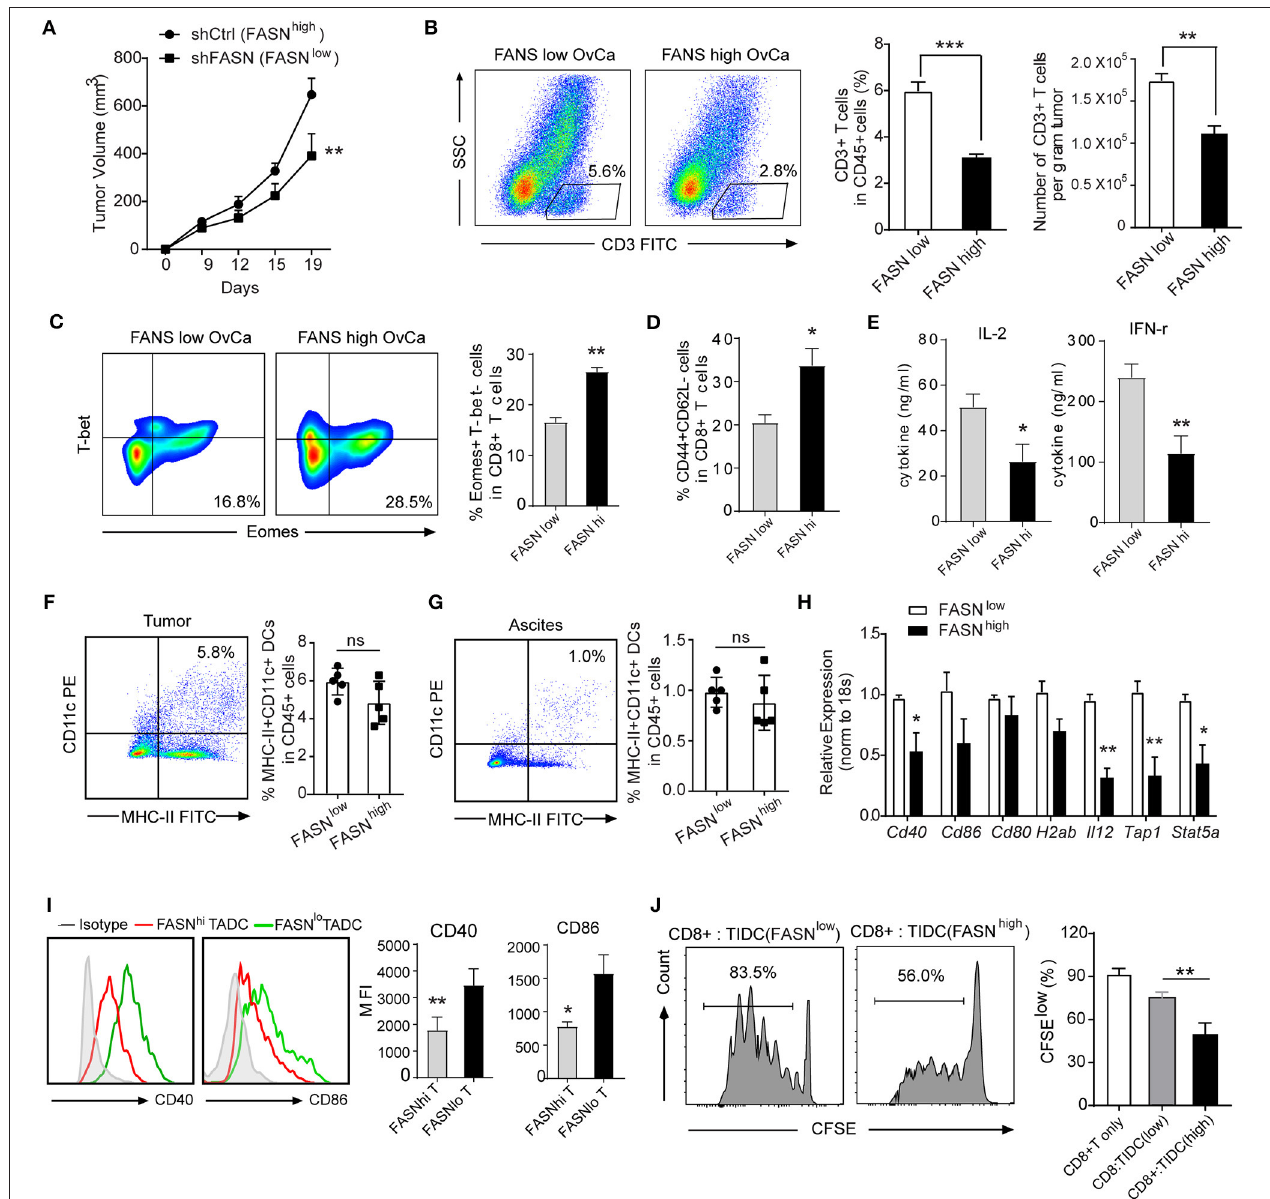
FIGURE 2 | Ovarian cancer with elevated FASN expression showed T cell exclusion and defective tumor-infiltrating DCs. (A) Tumor growth in synergetic mice after the inoculation of ID8 cell transfected with vehicle control (shCtrl: FASN high ) or knocking-down FASN (shFASN: FASN low ). (B) Representative example out of five for flow cytometry analyzing tumor-infiltrating CD3 + T cells in ID8 tumor-bearing mice with high (FASN high ) or low expression of FASN (FASN low ) on day 15. Statistical bar graph showed CD3 + T cells depicted as percentage living CD45 + cells and absolute numbers per gram tumor. n = 10. (C) Representative color contour plots examining Eomes + T-bet − exhausted CD8 + T cells from mice with shCtrl-ID8 or shFASN-ID8 tumor, and quantification of Eomes + T-bet − cells in CD8 + T cells was shown. (D) Quantification of tumor infiltrated CD44 + CD62L − cell population in CD8 + T cell from tumor-bearing mice transplanted with shFASN-ID8 or shCtrl-ID8 ( n = 10). (E) Analysis of cytokine IL-2 and IFN-r in the supernatant of sorted CD3 + T cells isolated from FASN low or FASN high -ID8 tumors with anti-CD3/CD28 stimulation ( n = 10). (F,G) Flow cytometry analysis and quantification of MHC-II + CD11c + dendritic cells in the tumor (F) and ascites (G) of mice with the inoculation of shCtrl-ID8 (FASN low ) or shFASN-ID8 (FASN high ) ( n = 10). (H) mRNA expression of indicated DCs associated genes in TIDCs sorted from ID-8 transplanted mice with FASN low or FASN high . The results were normalized to the level of expression of 18sRNA. (I) Representative flow cytometry analysis and quantification of CD40 and CD86 on MHC-II + CD11c + cells from tumor-bearing mice transplanted with FASN low ID8 or FASN high ID8 cells. ( n = 10). (J) In vitro immunostimulatory activity of tumor-infiltrating CD11c + cells purified from FASN low or FASN high ID-8 tumor-bearing mice. Representative histograms of CD8 + T cell proliferation at CD8 + to CD11c + cell ratio 10:1 (left panel) and quantification of CD8 + T cell proliferation using CFSE dilution (right panel) ( n = 3). Data presented as mean ± SEM; representative of at least 3 independent experiments; ns, no significance; * P < 0.05; ** P < 0.01; *** P < 0.001.